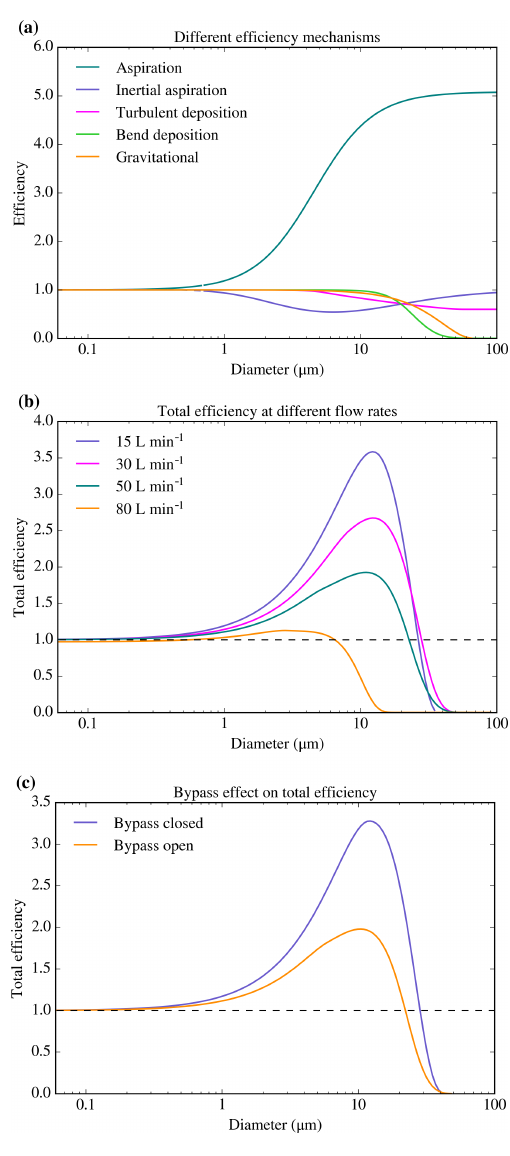
Figure 2. Theoretical efficiencies of the filter inlet system. (a) Effi- ciencies of the four mechanisms considered in this work for a total flow rate of 50Lmin − 1 . We have assumed a dynamic viscosity of 1 . 82 × 10 − 5 kgm − 1 s − 1 (value for 0 ◦ C) and a particle density of 1000kgm − 3 . The speed of the air mass ( U 0 ) was 110 m s − 1 , a typical FAAM BAe-146 flying speed at low altitudes. (b) Total ef- ficiency for four different total flow rates. For the 80Lmin − 1 case, turbulent deposition through the whole line was considered since the flow was turbulent through the whole pipe. (c) Total efficiency considering all the described mechanisms for a 20Lmin − 1 filter flow rate with the bypass closed and a 20Lmin − 1 filter flow rate with the bypass open (considering a bypass flow of 25Lmin − 1